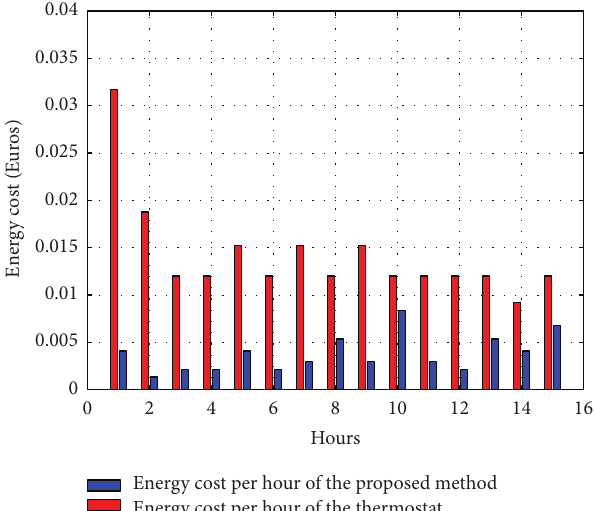
Figure 10: Energy consumption cost comparison between thermo- stat and